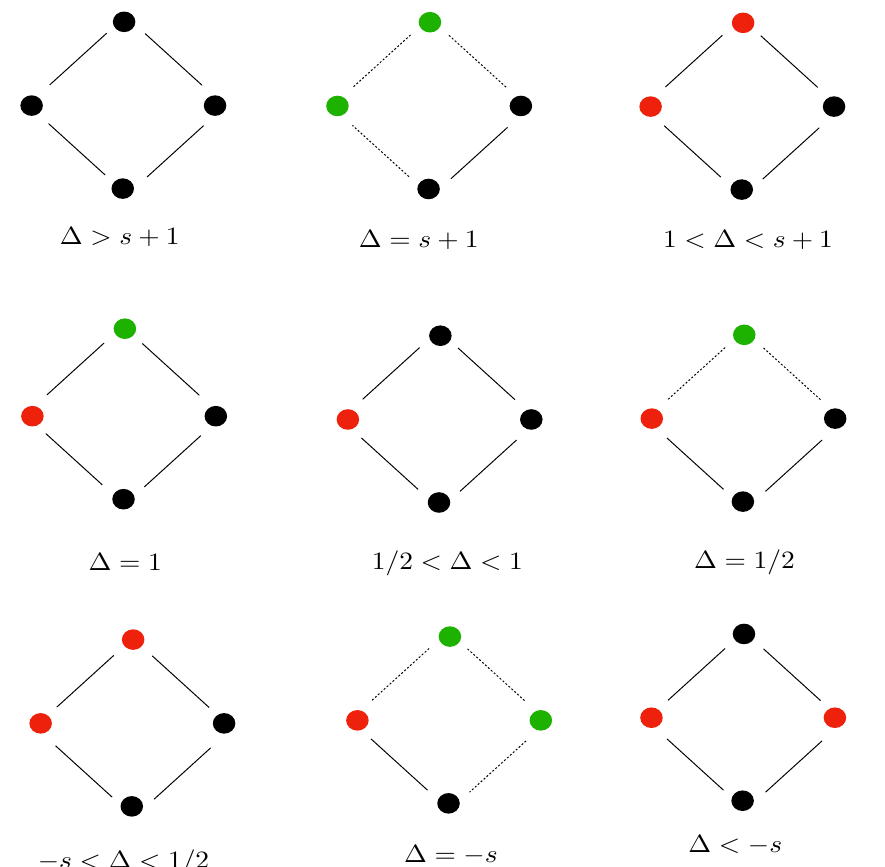
Figure 2 . Relative norms of the conformal primaries within the f s g the various values of (cid:1). Black is positive norm, red is negative norm, and green is zero norm. We see the unitarity bound (cid:1) (cid:21) s + 1; all the multiplets below this bound have at least one negative norm conformal primary and are thus